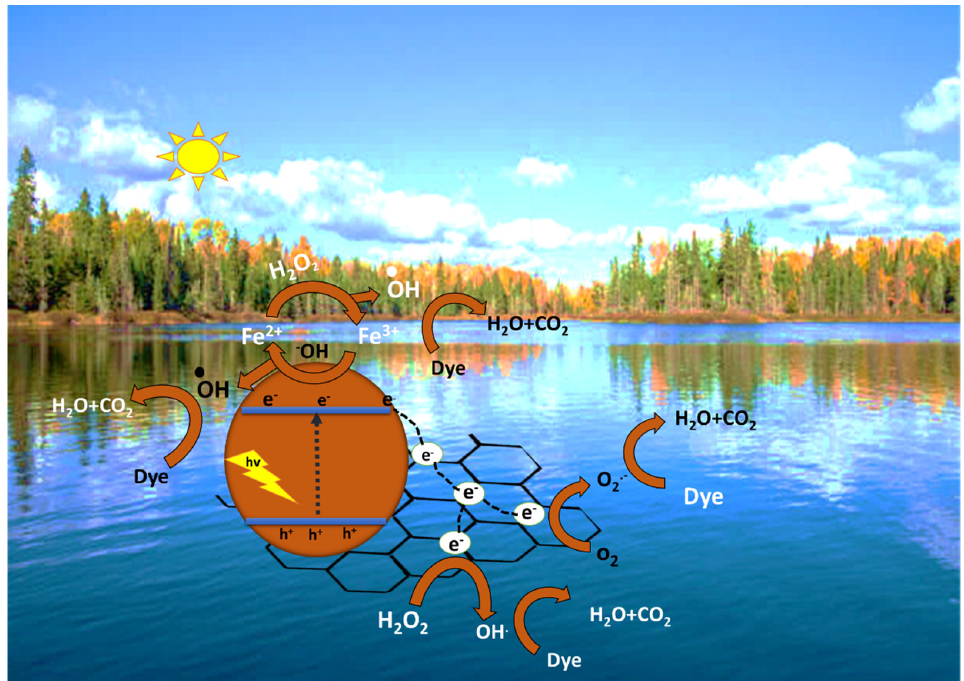
Scheme 3. Schematic representation for mechanism of dyes’ photodetoxification by MFGNs with strong reduction ability.